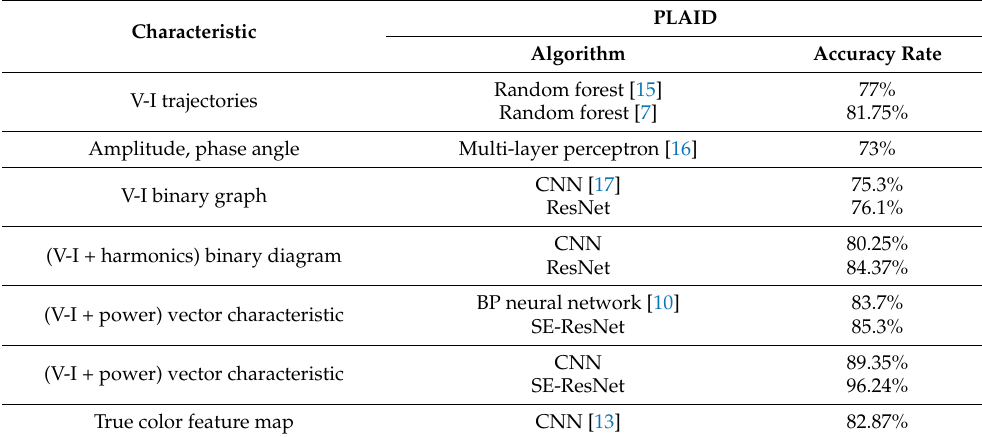
Table 6. Comparison of results of different methods based on PLAID data sets. Characteristic